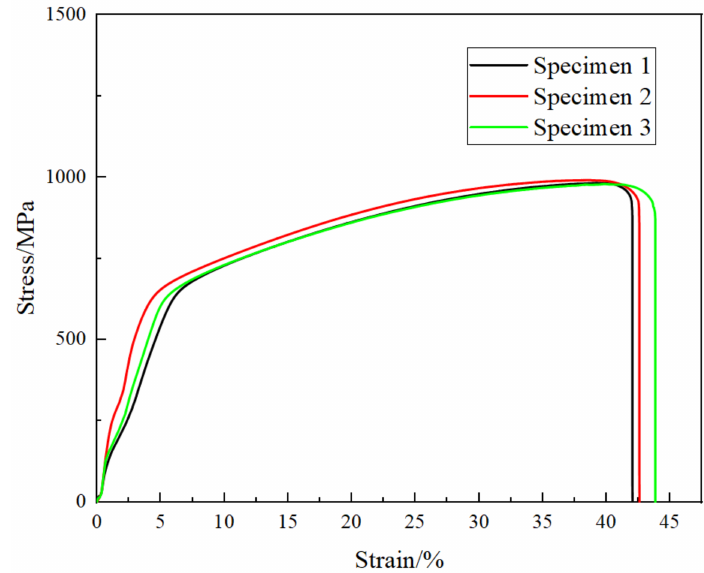
Figure 4. Stress–strain curve of Co 32 Cr 28 Ni 32 . 94 Al 4 . 06 Ti 3